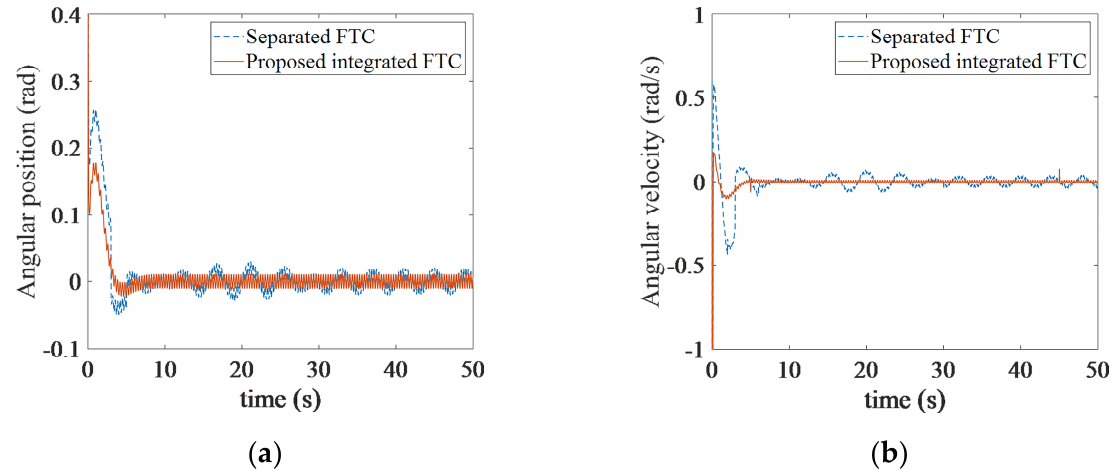
Figure 9. ( a ) Fault-tolerant control of motor angular position; ( b ) fault-tolerant control of motor angular velocity. Assume that the speed of the forklift is v u = 15 km/h, the input sinusoidal torque of the driver is T d = 3 sin ( 0.4 π t ) and the input torque period of the driver is 10 s, as shown in Figure 10. The integrated FTC test and decentralized FTC test were carried out when the actuator gain change fault occurred at 12.5 s in the EPS system. The integrated FTC test and decentralized FTC test were carried out when the EPS system was fault-free and the EPS system was fault-tolerant at the same time. As shown in the figure, when a fault occurs, the power torque of the EPS system fault is quickly restored to the power torque value of the EPS system without faults. At the same time, the integrated design is faster and better than the decentralized design, so as to reflect the improvement of the reliability of the integrated FTC on the EPS system. In the same way, real vehicle tests were carried out for the actuator constant deviation fault and the mixed fault of constant deviation and gain variation, and the results were consistent with the fault of gain variation.